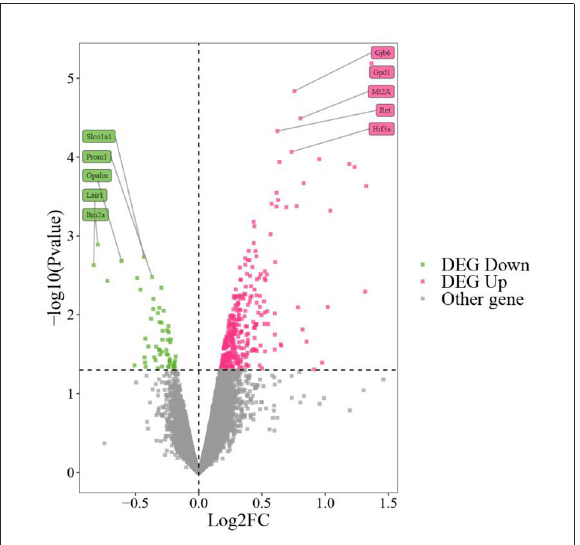
FIGURE1 GSE139220 volcano map. The top 10 genes with the most significant P values are marked on the